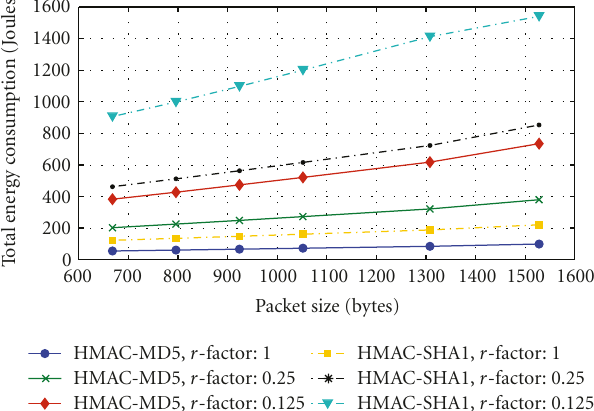
Figure 16: Total energy required for authenticating 500MB data,